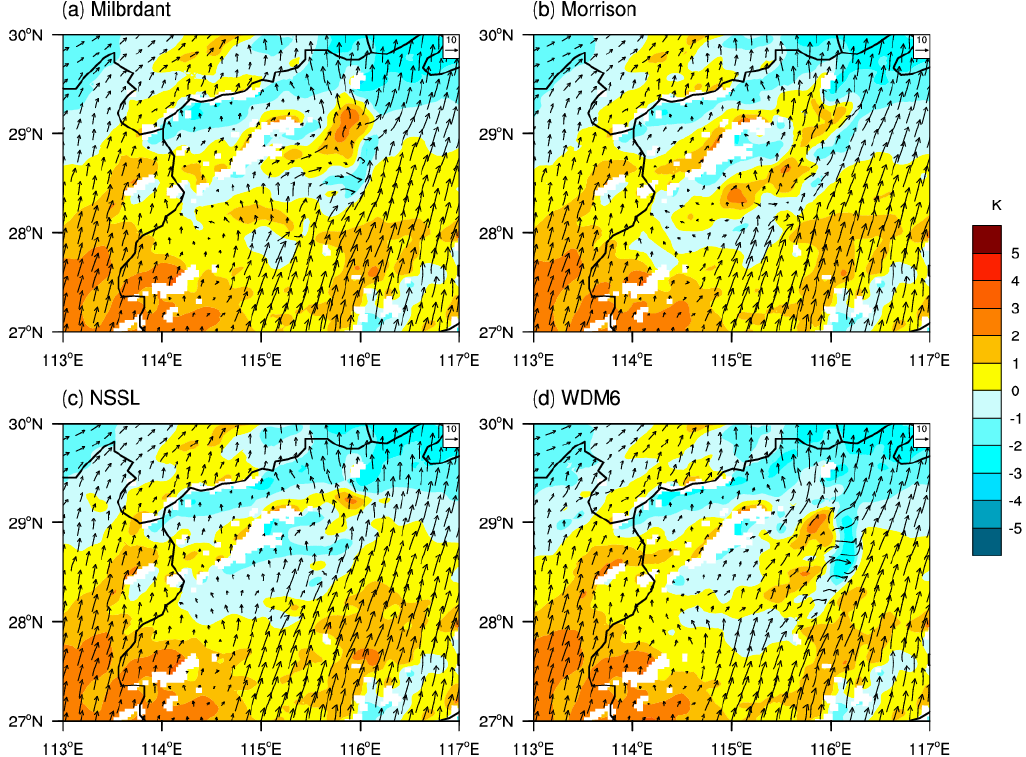
Figure 15. The 925 hPa wind fields (vector, units: m·s −1) and perturbation potential temperature fields (shaded, unit: K) with four different double−moment MP schemes at 2230 UTC 15 April 2016. The square box in the upper − right corner shows 10 m·s −1 wind.